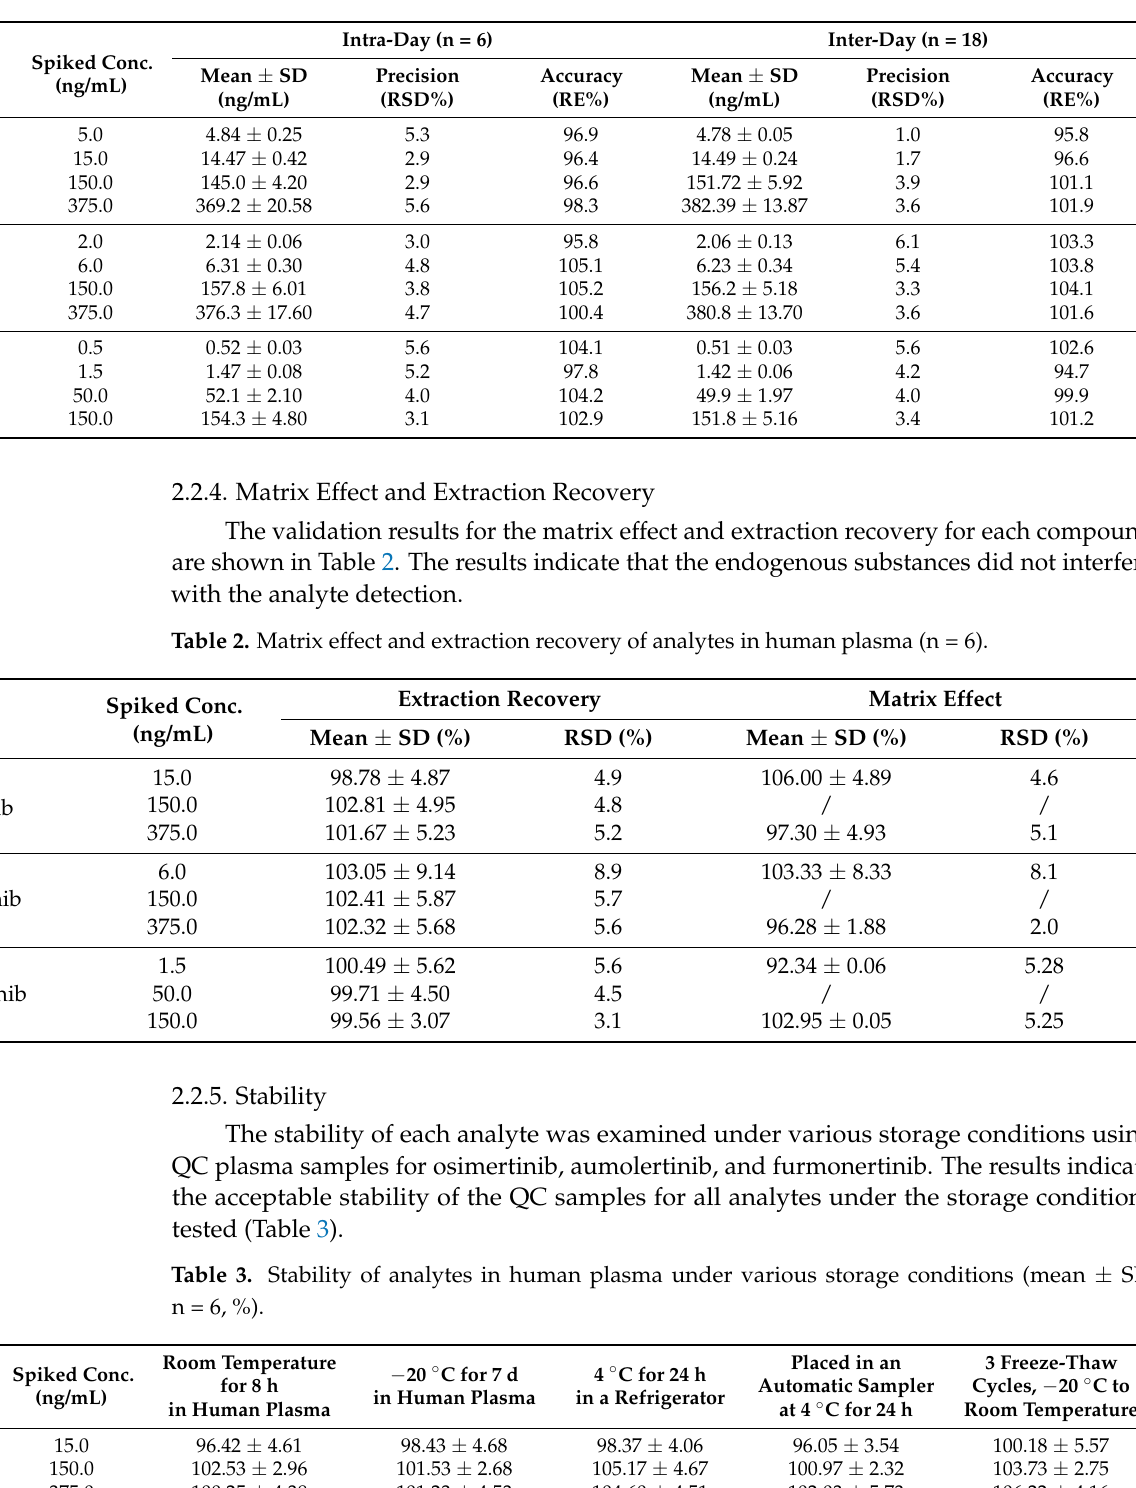
Table 1. Precision and accuracy data of osimertinib, aumolertinib, and furmonertinib in human plasma (n = 6).